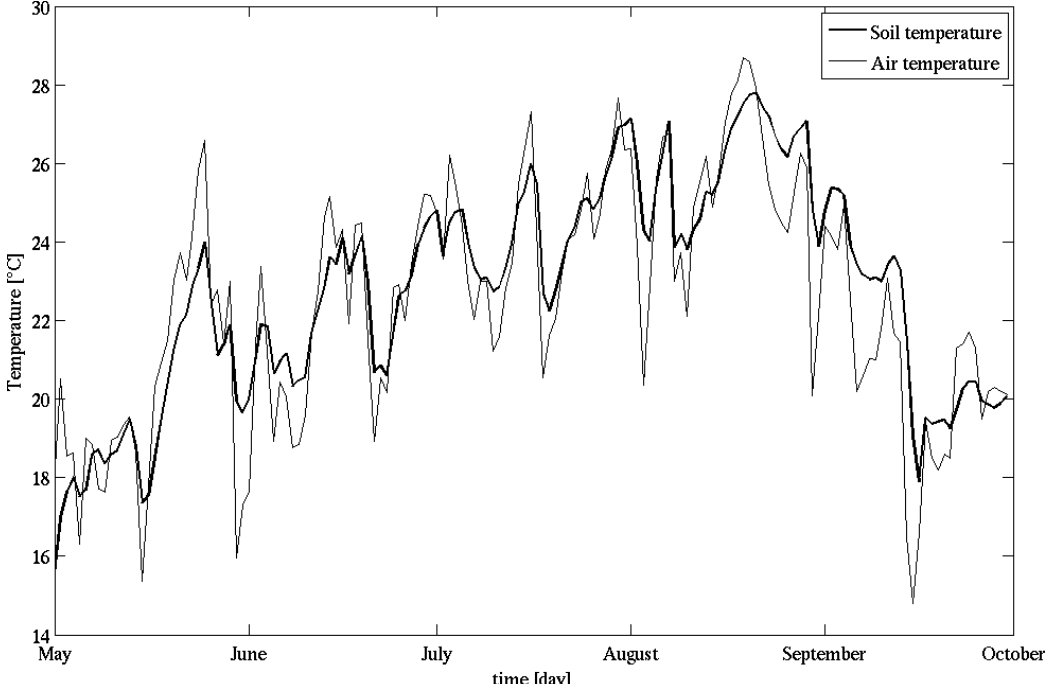
Figure 6. Air temperature measured in the shelter, above the canopy, compared to soil temperature measured at 15 cm below the soil surface near Barbera vine rows at Cocconato, during the 2009 season at Cocconato (both in ◦ C).